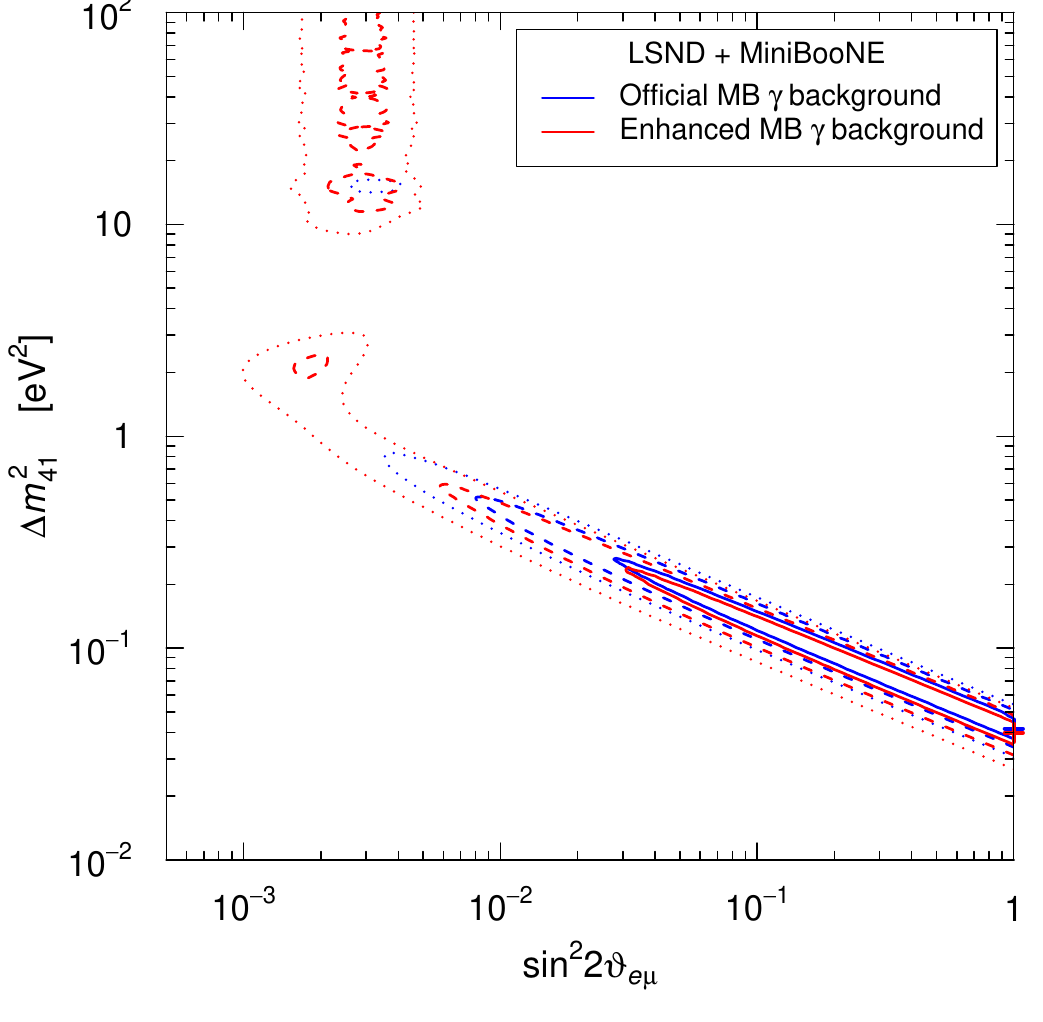
Figure 3 . Contours enclosing 1 σ (solid), 2 σ (dashed), and 3 σ (dotted) allowed regions in the ( sin 2 2 ϑ eµ , ∆ m 2 ) plane obtained from the analysis of LSND and MiniBooNE data without (blue) 41 and with (red) the enhanced single- γ